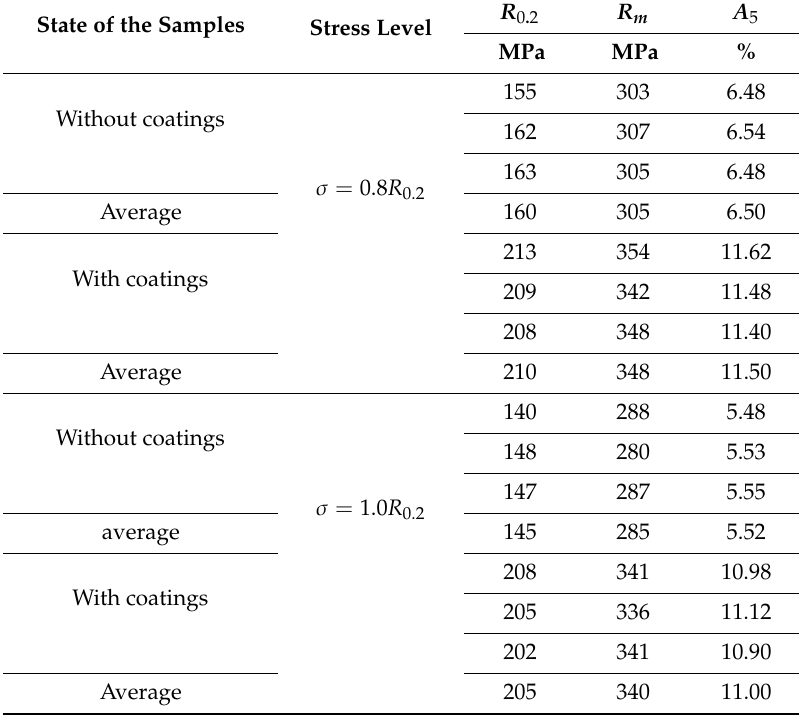
Table 4. Mechanical properties of samples with and without coatings of AlMg6 alloy after exposure to stress corrosion at time t = 1000